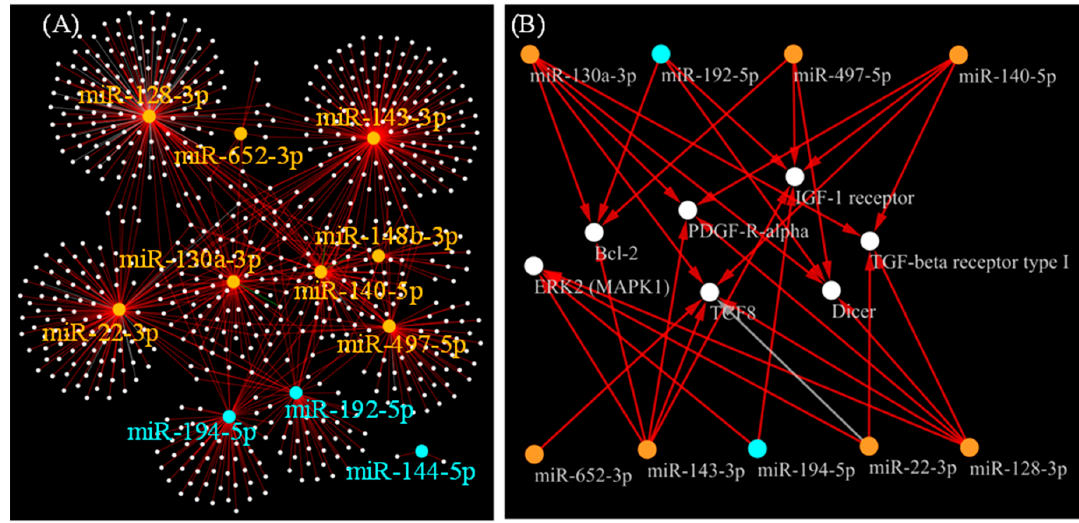
Figure 5. Network model representing miRNA-target gene relationship. ( A ) Network model representing miRNA-target gene interactions is presented, focusing on 11 miRNAs whose plasma levels showed correlations with both CHA 2 DS 2 -VASc score and CA operation, by referring to Metabase knowledgebase. White dots represent possible target genes. Orange and cyan dots represent miRNAs whose plasma levels showed positive and negative correlation with CHA 2 DS 2 -VASc score, respectively. Supporting literature information for the miRNA-target gene relationships is provided in Figure S1, and the network model file is provided as Figure S2; ( B ) Possible target genes that have ≥ 4 edges connected to either of the selected 11 miRNAs are presented. Orange and blue nodes indicate miRNAs whose plasma levels showed positive and negative correlations to CHA 2 DS 2 -VASc scores, respectively. Red and gray edges represent negative and unknown regulations of the miRNAs on their target genes, respectively.